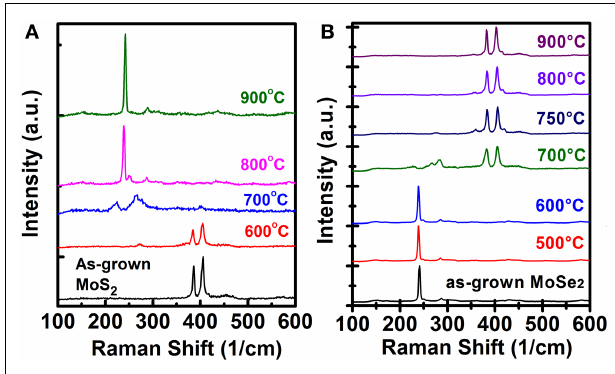
FIGURE 2 | Raman spectra for the (A) MoS 2 and (B) MoSe 2 flakes before and after selenization/sulfurization at different temperatures are shown